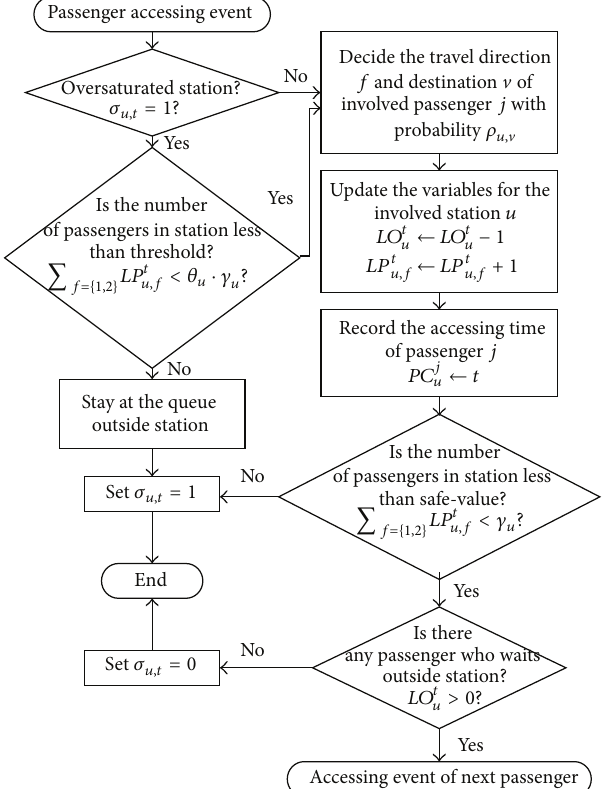
Figure 4: Flowchart of passenger accessing event.